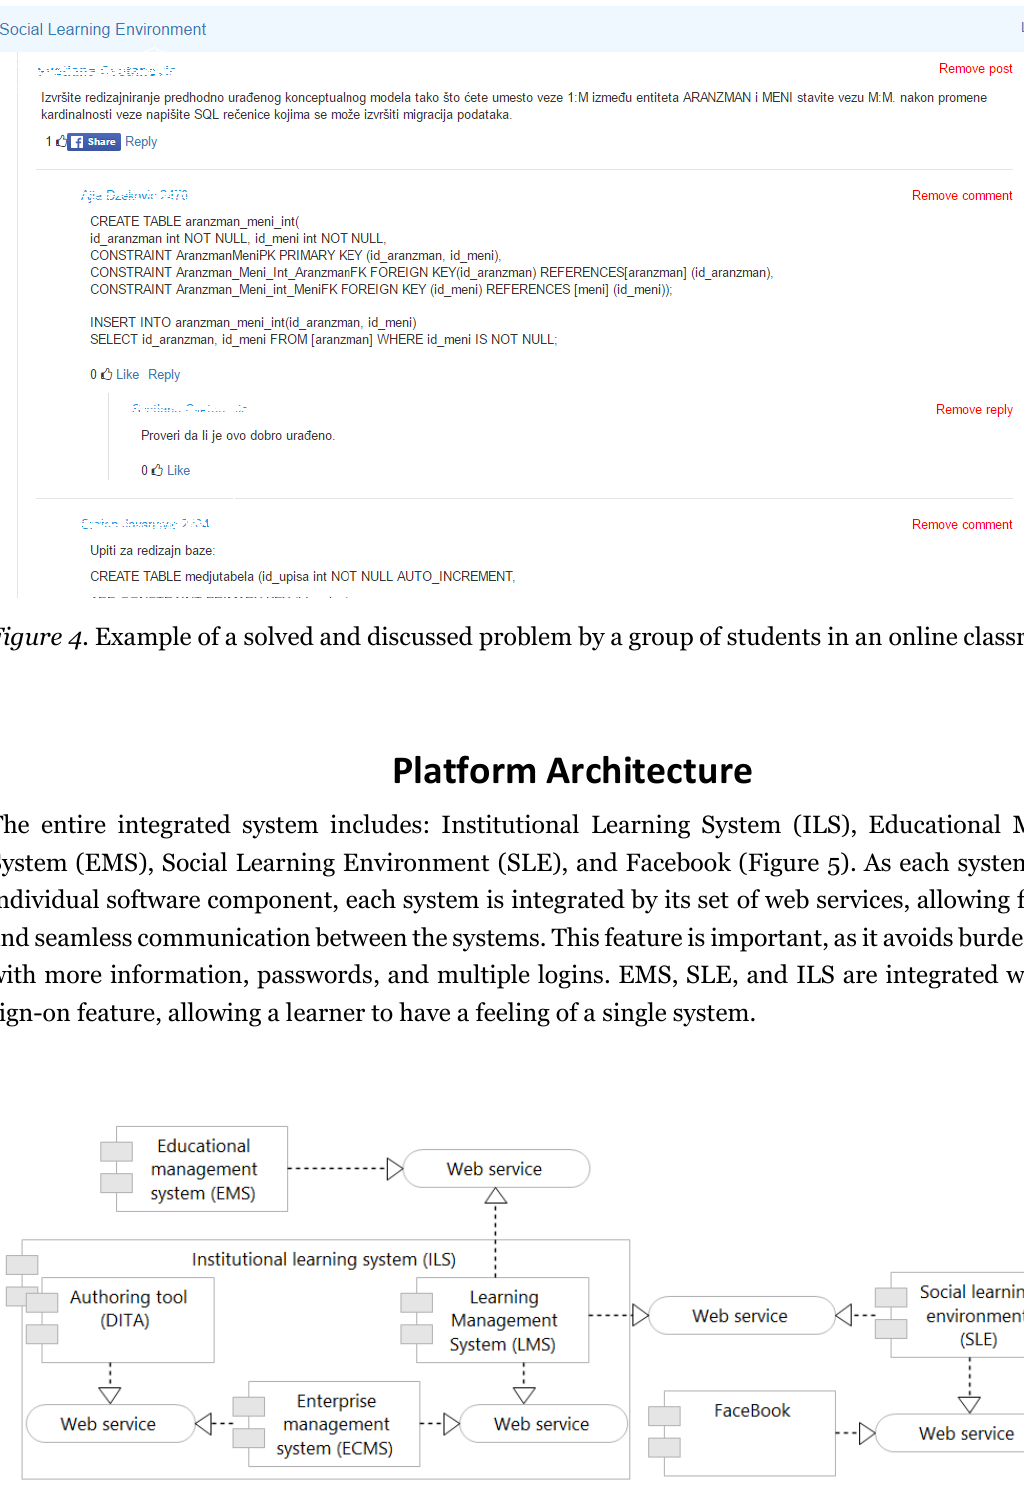
Figure 5. Platform architecture of the integrated